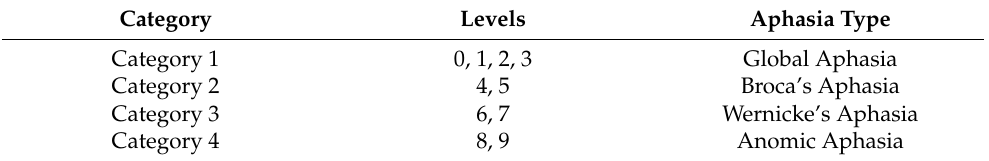
Table 2. Grouping aphasia severity levels into categories and aphasia types.